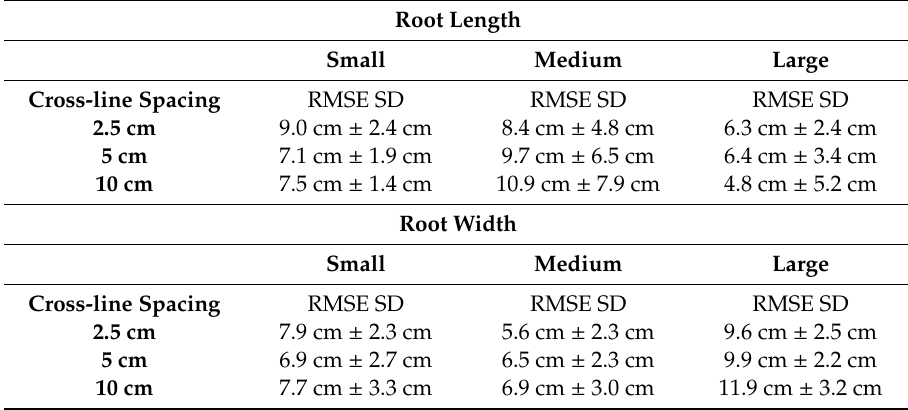
Table 2. Cross-line spacing for root length measures. The root mean squared error (RMSE) and standard deviation (SD) for each root category are